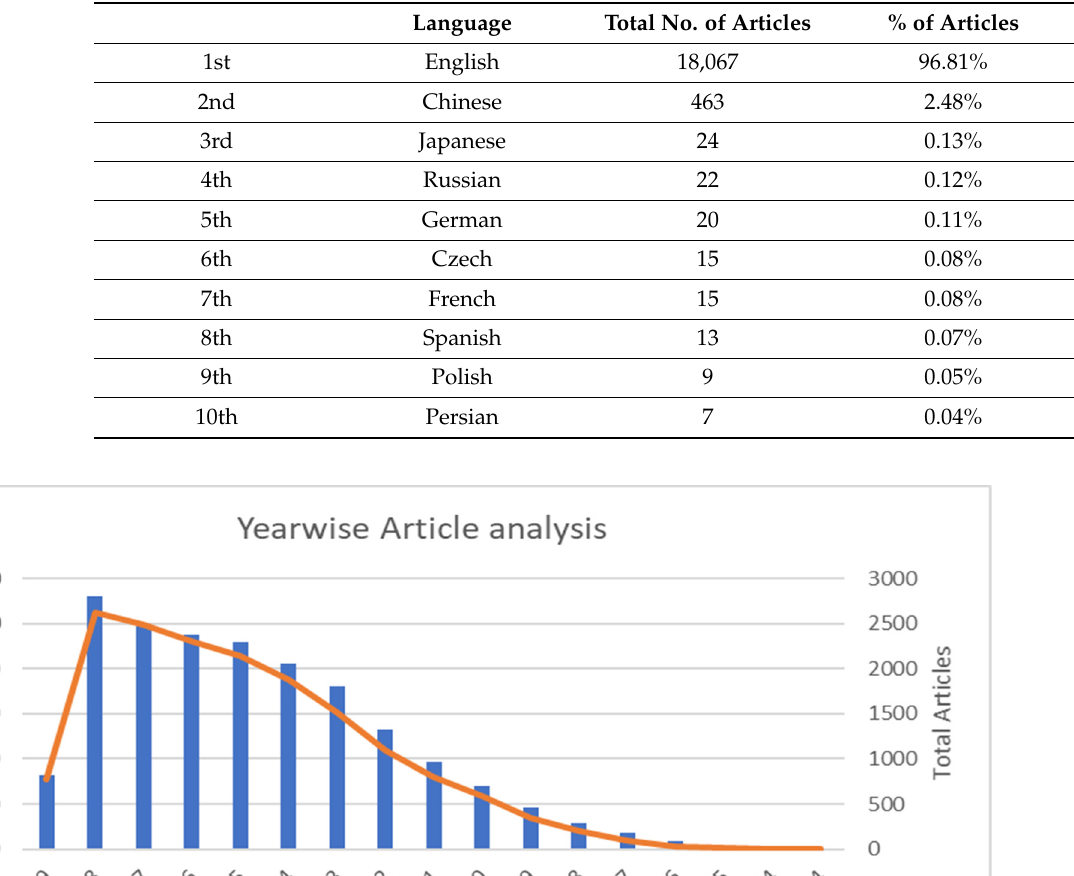
Table 2. Top 10 languages of retrieved articles on miRNA in cancer (2003–2019).